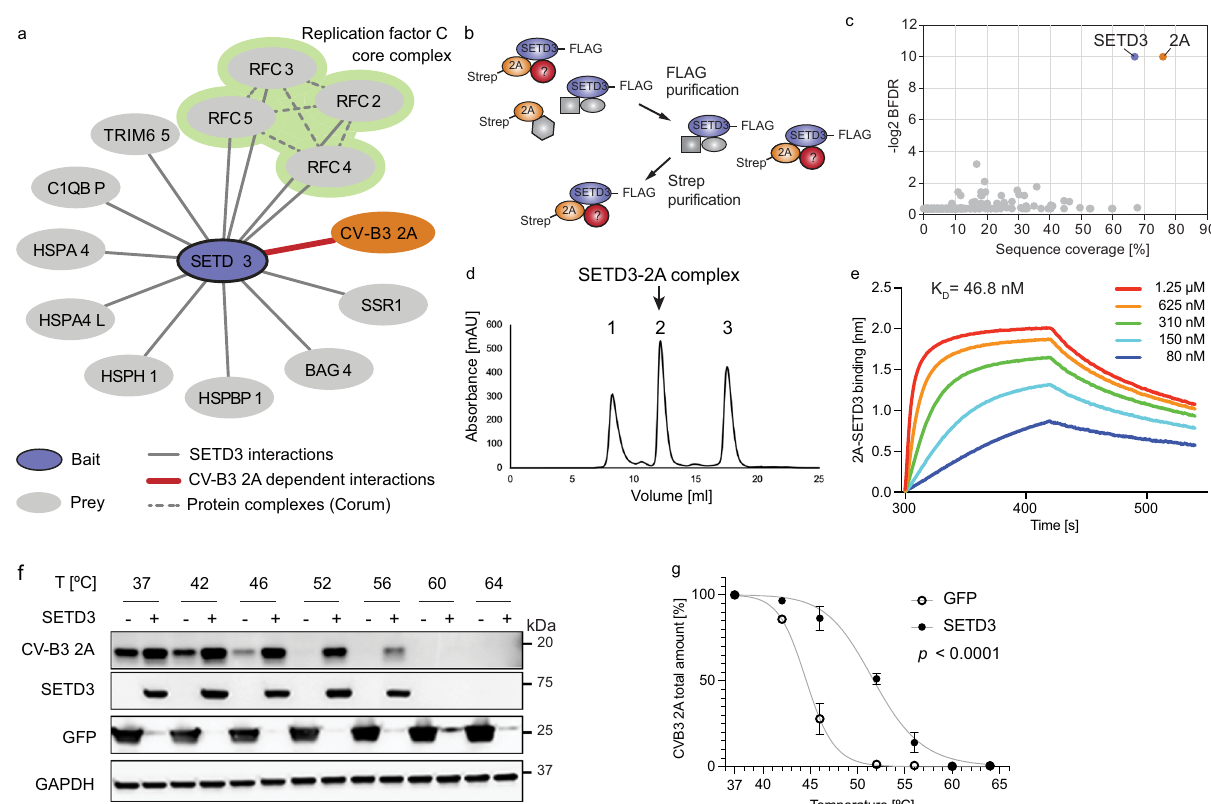
Fig. 1 | CV-B3 2A and SETD3 form a stable complex. a High-con fi dence SETD3 interacting host proteins in the presence and absence of CV-B3 2A with a Bayesian False Discovery Rate (BFDR)<0.05 generated using AP-MS. See also Supplemen- tary Dataset 1. b Schematic of sequential FLAG-Strep AP (double-AP) experimental fl ow. c Dot plot representation of proteins identi fi ed in double-AP experiment. Sequence coverage of detected proteins versus SAINTexpress BFDR is shown. Proteins passing the signi fi cance threshold of BFDR<0.05 are highlighted in red. See also Supplementary Dataset 2. d Puri fi cation of reconstituted SETD3-2A com- plex. Size exclusion column elution pro fi le after puri fi cation and complex recon- stitution is shown. Aggregated material (peak 1), the complex of 2A-protease with SETD3 (peak 2), and monomeric 2A (peak 3). Puri fi ed complex from peak 2 was used for structure determination by cryo-EM. See also Supplementary Fig. 1. e Binding of puri fi ed SETD3 to 2A protein as measured by biolayer interferometry. See also Supplementary Figs. 1 – 5. Binding curves for varying input concentrations (different colours) of SETD3. Equilibrium constant K D as calculated by the